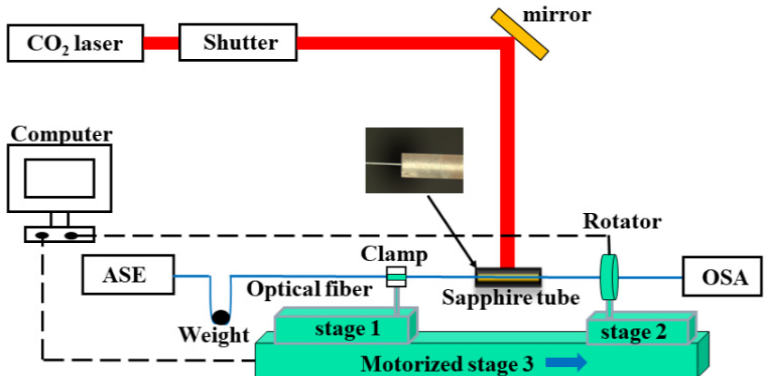
Figure 15. Setup for fabrication of the HLPGs by using the Sapphire tube-based CO 2 laser heating method. Adapted with permission from Ref. [14] © The Optical Society.